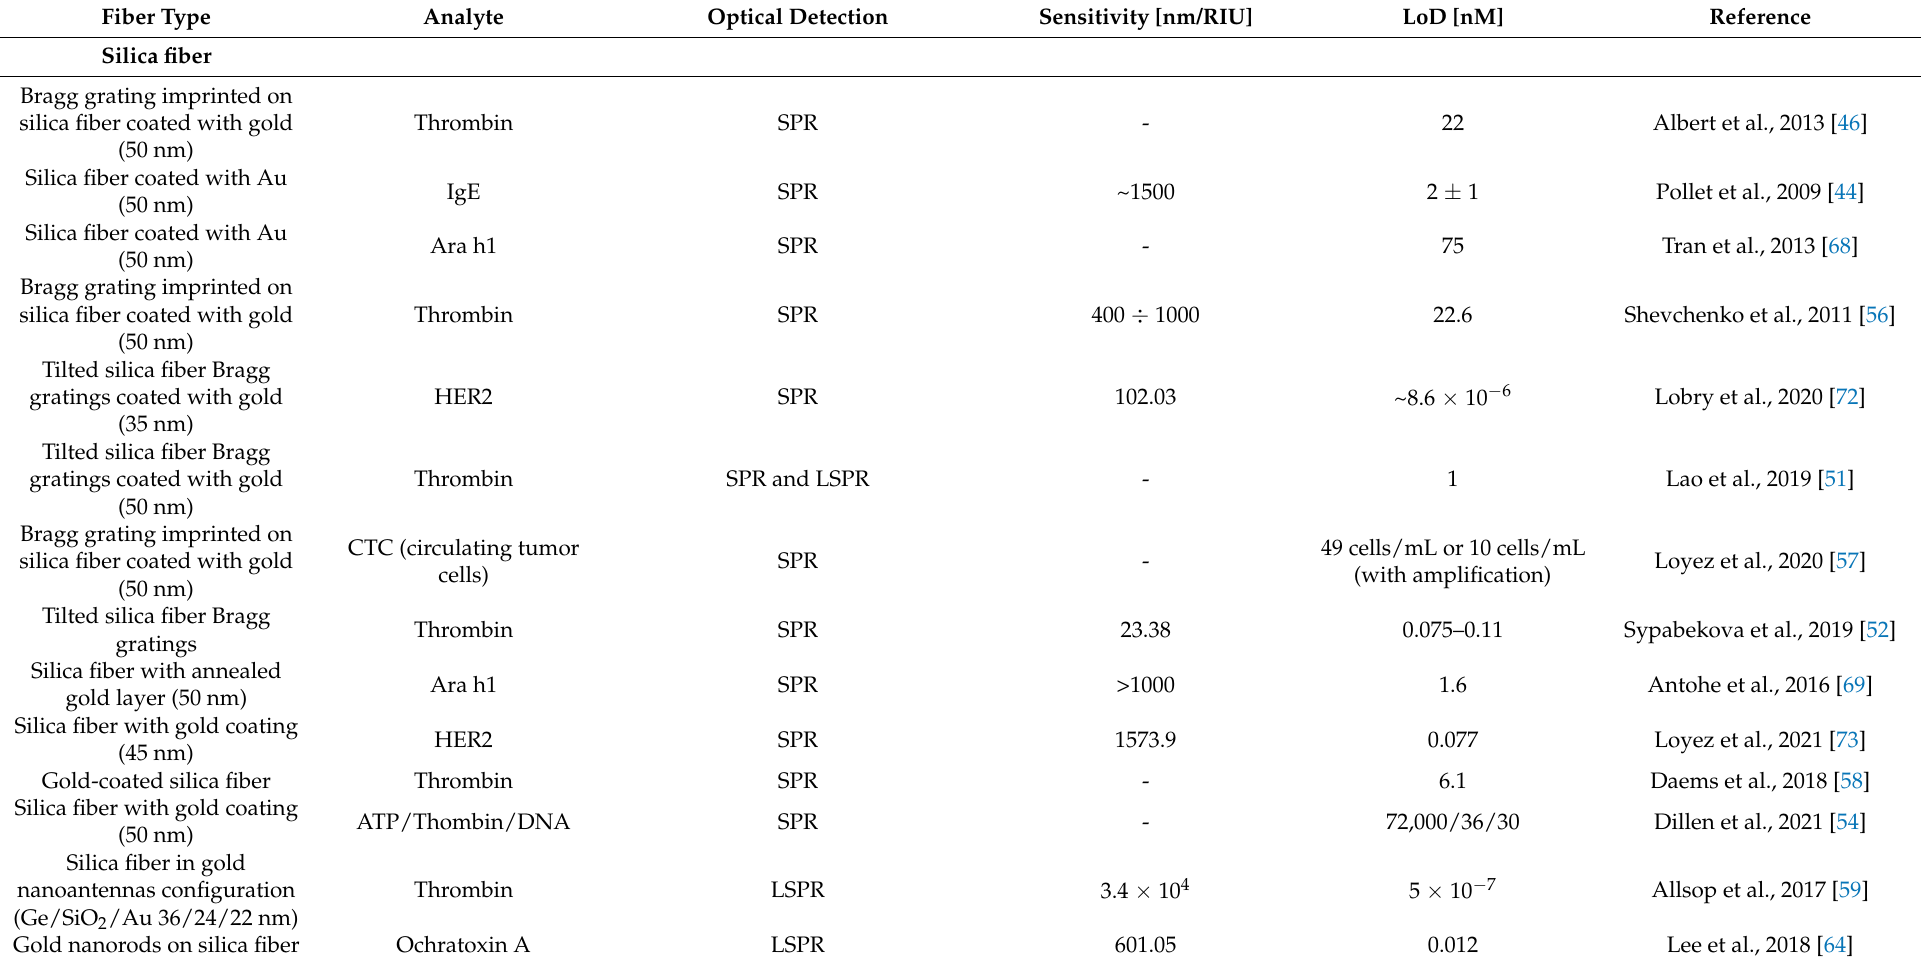
Table 2. Aptamer-based silica or plastic optical fiber plasmonic sensor